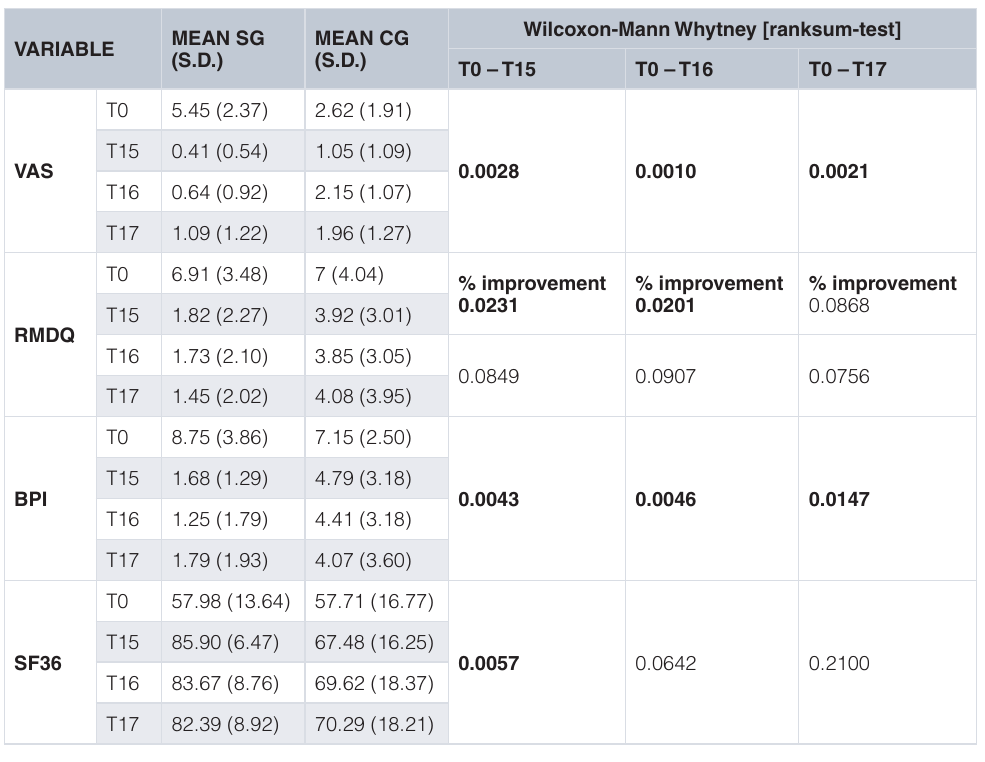
Table 2. Mean, standard deviation and statistical significance of measured outcomes. S.D. = standard deviation.